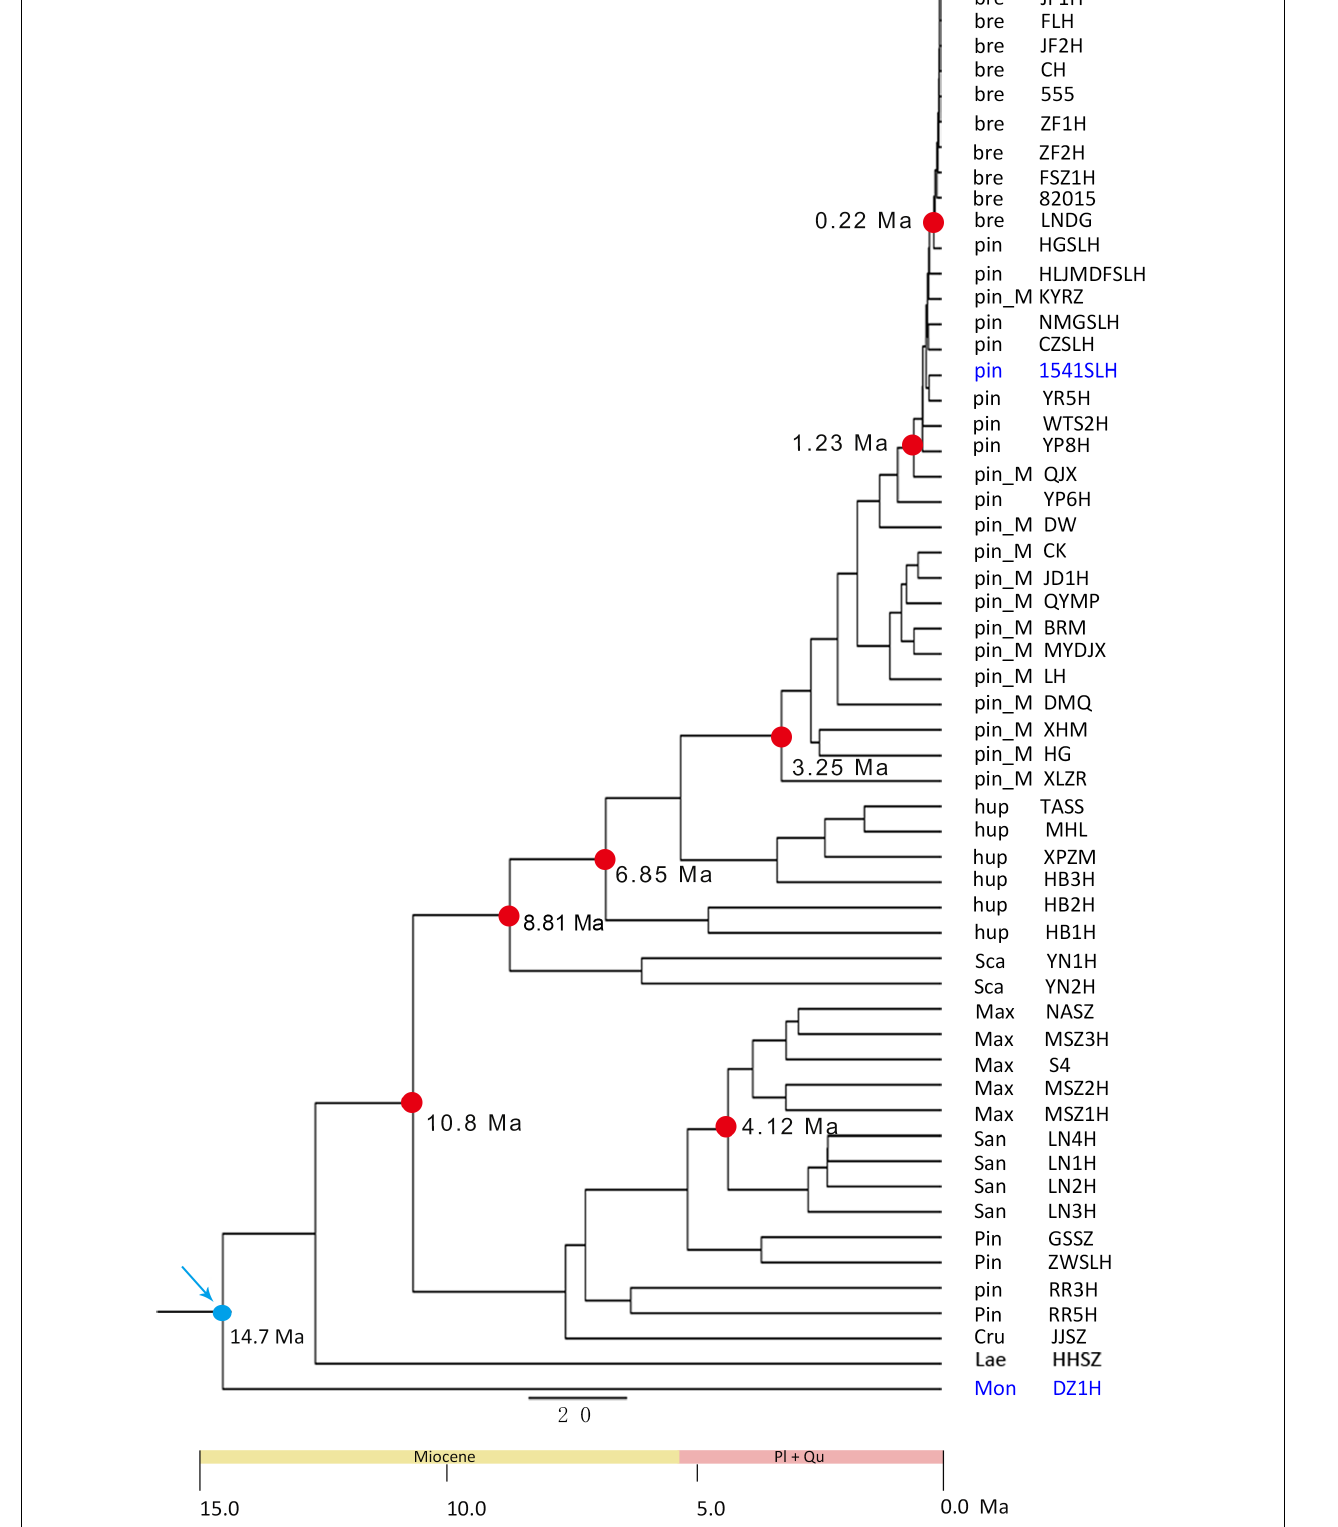
FIGURE 4 | Time-calibrated phylogeny inferred from SLAF-seq data in BEAST V.1.7.5 using node age based on fossil data. Blue arrows designate calibrated node (14.7 Ma). The blue words represent the fossils for calibration. The dots represents the split time.